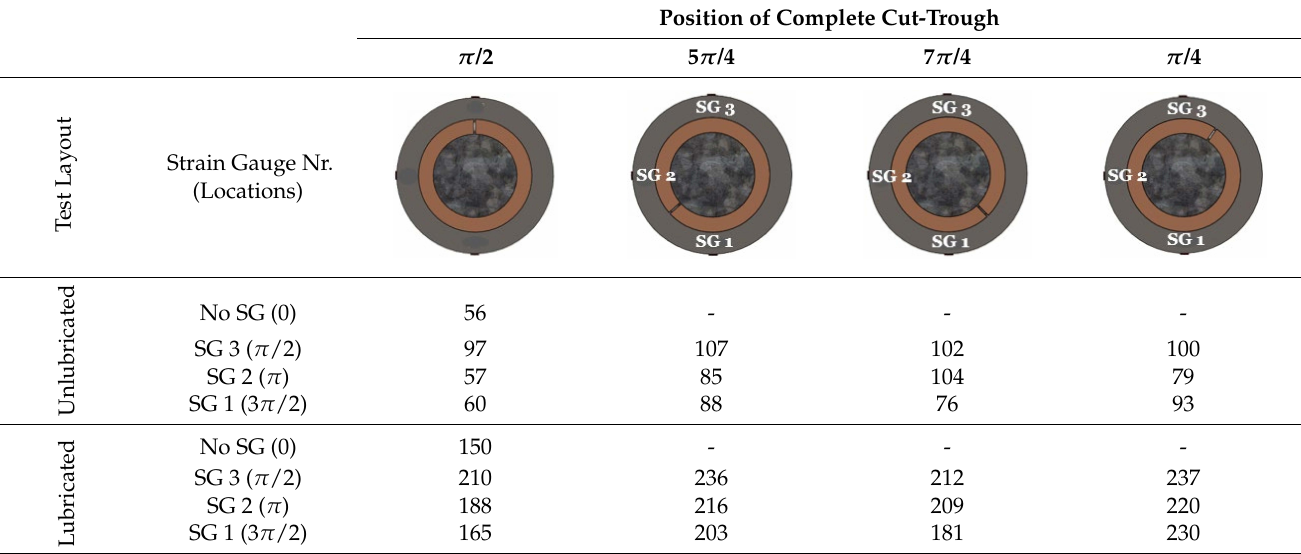
Table 3. Hoop stress [MPa] based on location of cut-through inside the test boss. Position of Complete